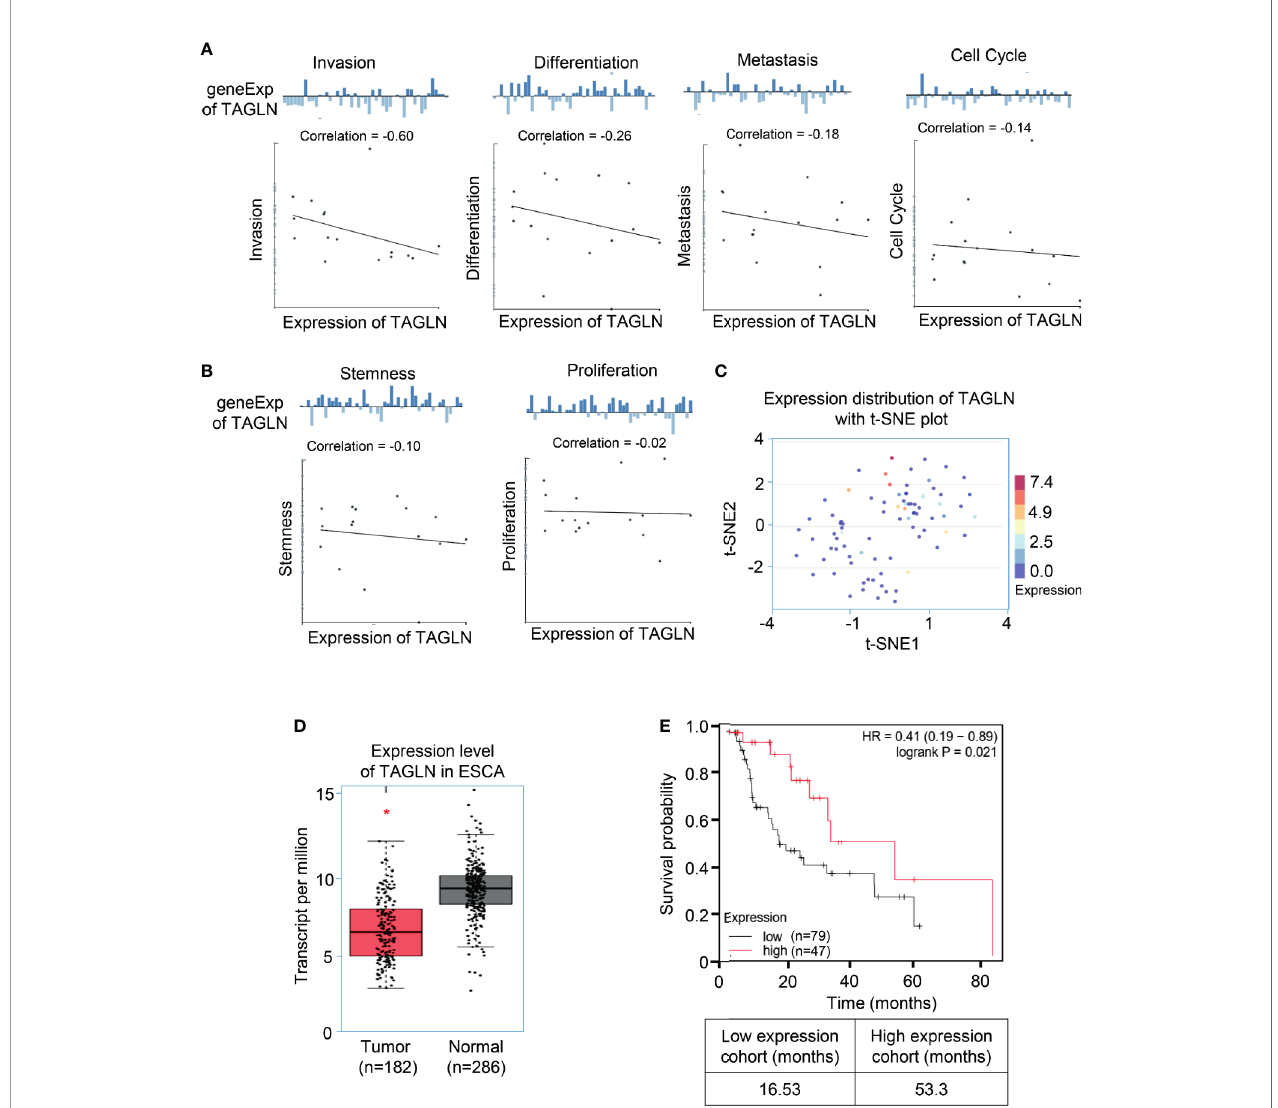
FIGURE 1 | The expression of Transgelin was low in esophageal squamous cell carcinomas, and its expression level was positively correlated with the prognosis of esophageal squamous cell carcinomas. (A) The average correlation between Transgelin and functional status of ESCC. The analysis results show that the expression level of Transgelin is negatively correlated with Invasion, Differentiation, Metastasis and Cell Cycle. (B) The expression level of Transgelin is negatively correlated with Stemness and Proliferation. (C) The distribution of Transgelin expression in tumors and the t-SNE diagram of all individual cells. (D) Expression level of Transgelin in ESCC. (E) The correlation between Transgelin expression and prognosis in patients with esophageal squamous cell carcinomas. *P <